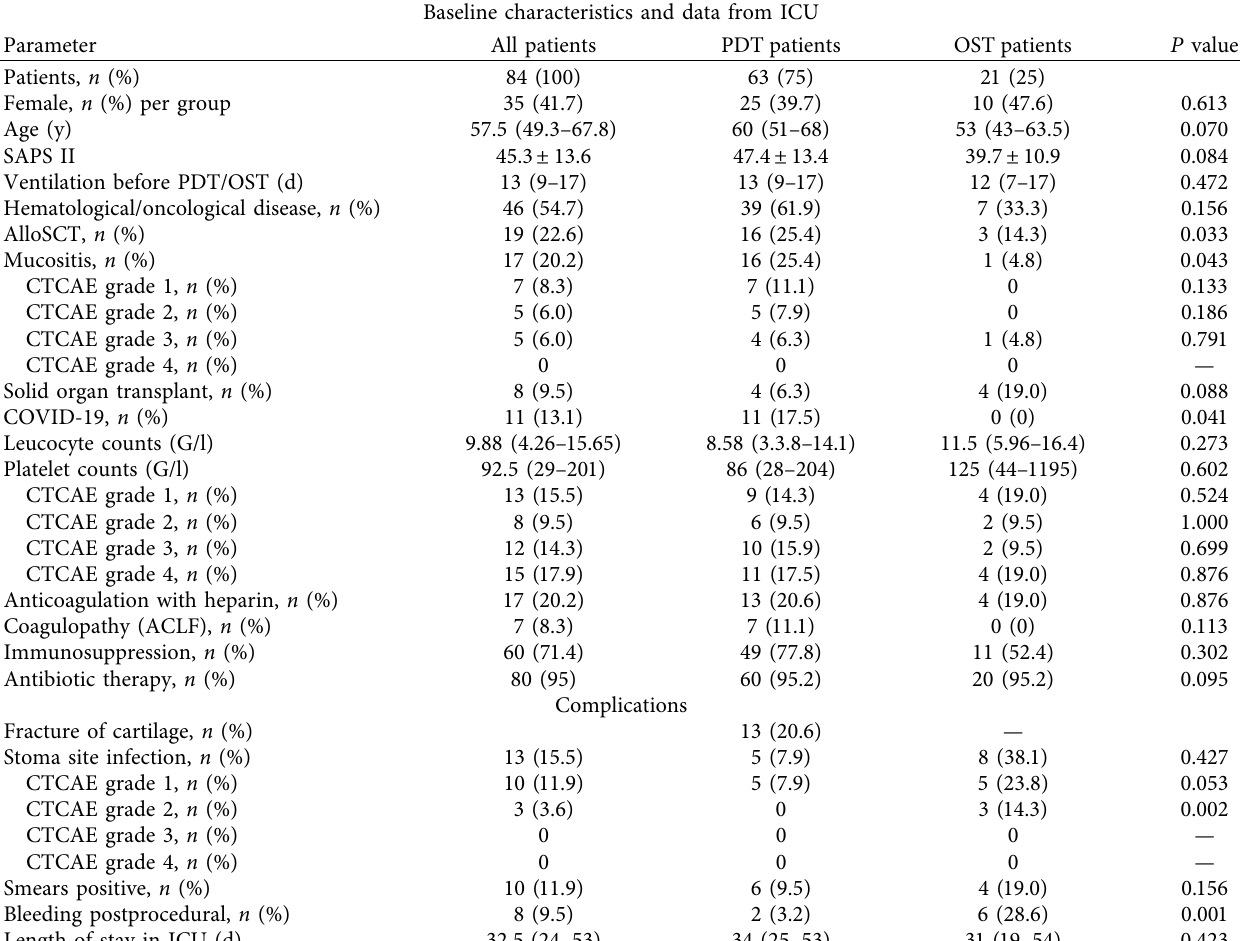
Table 1: Baseline characteristics and data from